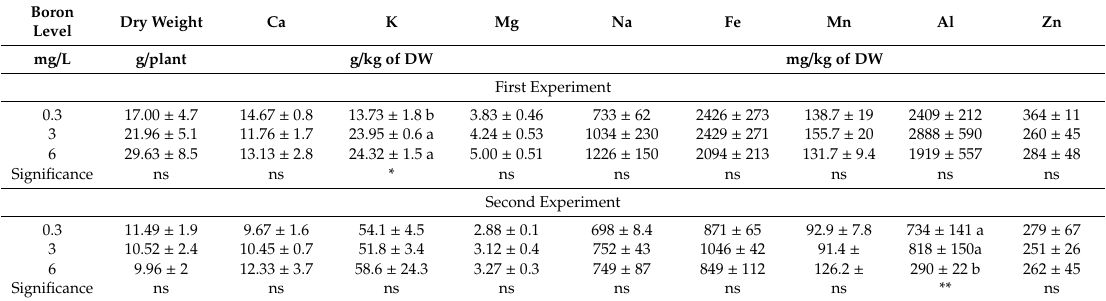
Table 5. E ff ects of di ff erent boron levels in the nutrient solution on dry weight and content of Ca, K, Mg, Na, Fe, Mn, Al, and Zn in wild (first experiment) and commercial (second experiment) purslane roots. Boron